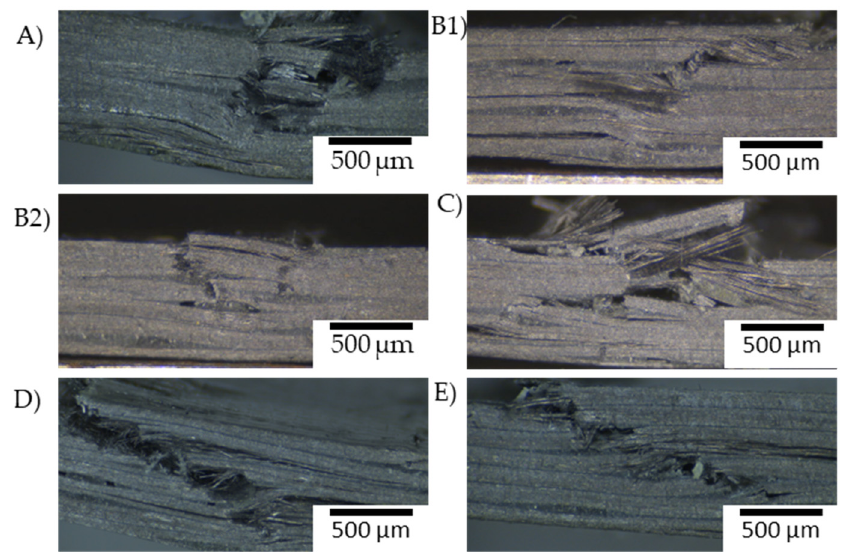
Figure 23. Analysis of crack propagation due to three-point bending test in carbon fibre interlayered with nanofibrous polyamide 6,6 veils: ( A ) No toughening; ( B ) Comparison of single-veil reinforce- ment of ( B1 ) compressive and ( B2 ) tensile area; ( C ) Comparison of reinforcement of two veils in compression; ( D ) Double veil reinforcement on the neural axis and ( E ) Fully interlayered carbon fibre stack with veil.